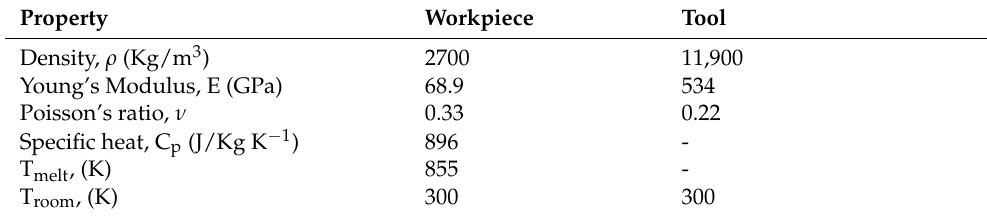
Table 2. Physical properties of workpiece and tool [33].